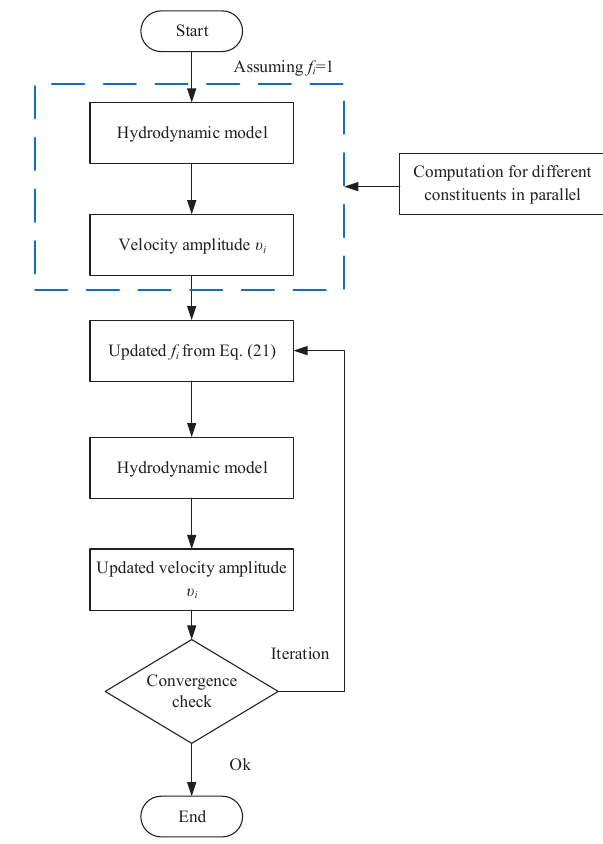
Figure 5. Computation process for tidal properties of different con- stituents in an